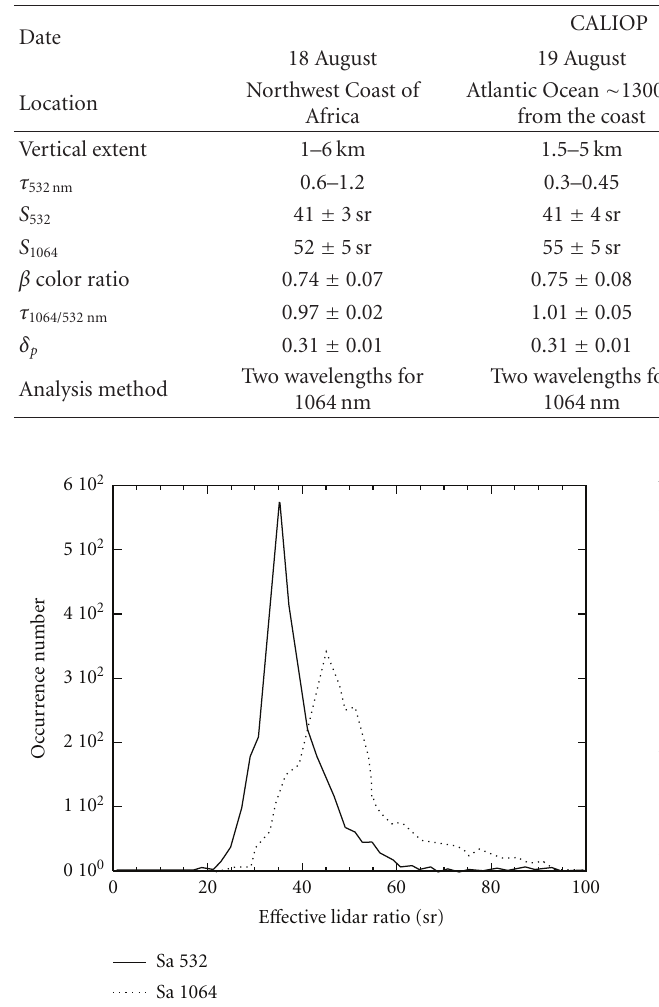
Figure 7: Occurrence number of e ff ective lidar ratios (the product of the naturally occurring lidar ratio and the instrument-specific multiple scattering factor at each wavelength) at 532 nm and 1064 nm for African dust derived from the first two and a half years of the nighttime CALIOP data acquired over land within a geo- graphical region of (12 ◦ N–30 ◦ N, 30 ◦ W–35 ◦ E) in the North Africa. The median/mean is 36.4/38.5 ± 9.2 sr at 532 nm and 47.7/50.3 ± 12.3sr at 1064 nm. Figure from